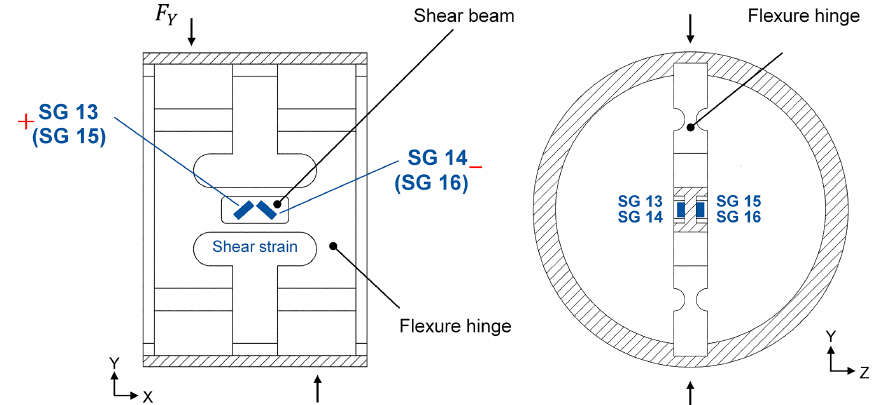
Figure 7. Design principle of the lateral force element.